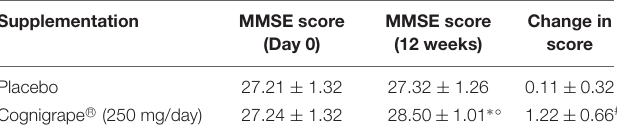
TABLE 2 | Mini Mental State Examination (MMSE) score before (Day 0) and after supplementation with Cognigrape or Placebo for 12 weeks.